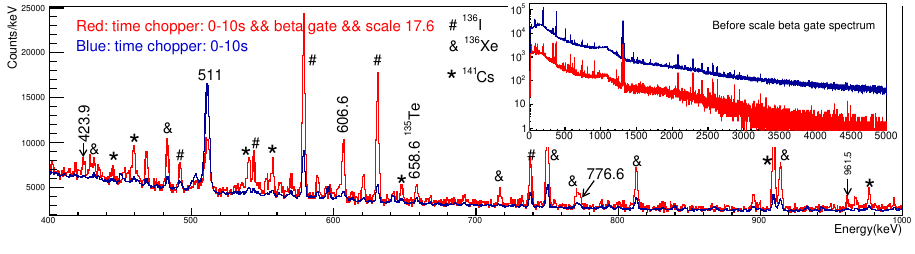
Figure 2. A β -gated (red) γ ray spectrum for 136 Te is compared with its un-gated γ ray spectrum (in blue). The transitions in 136 Te are marked with their energy